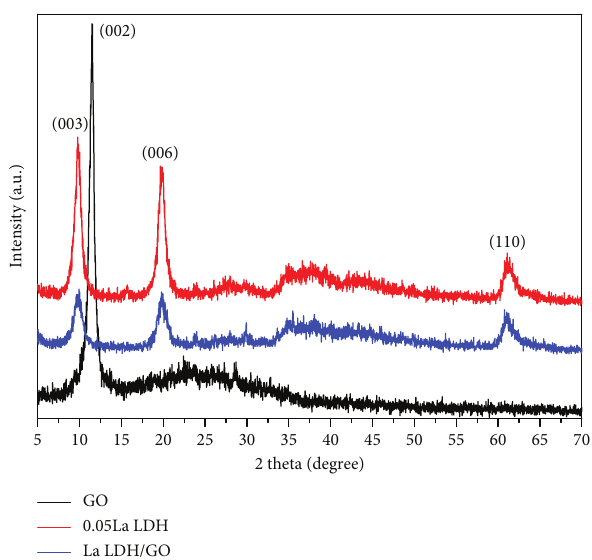
Figure 2: XRD spectra of GO, 0.05 La LDH, and La